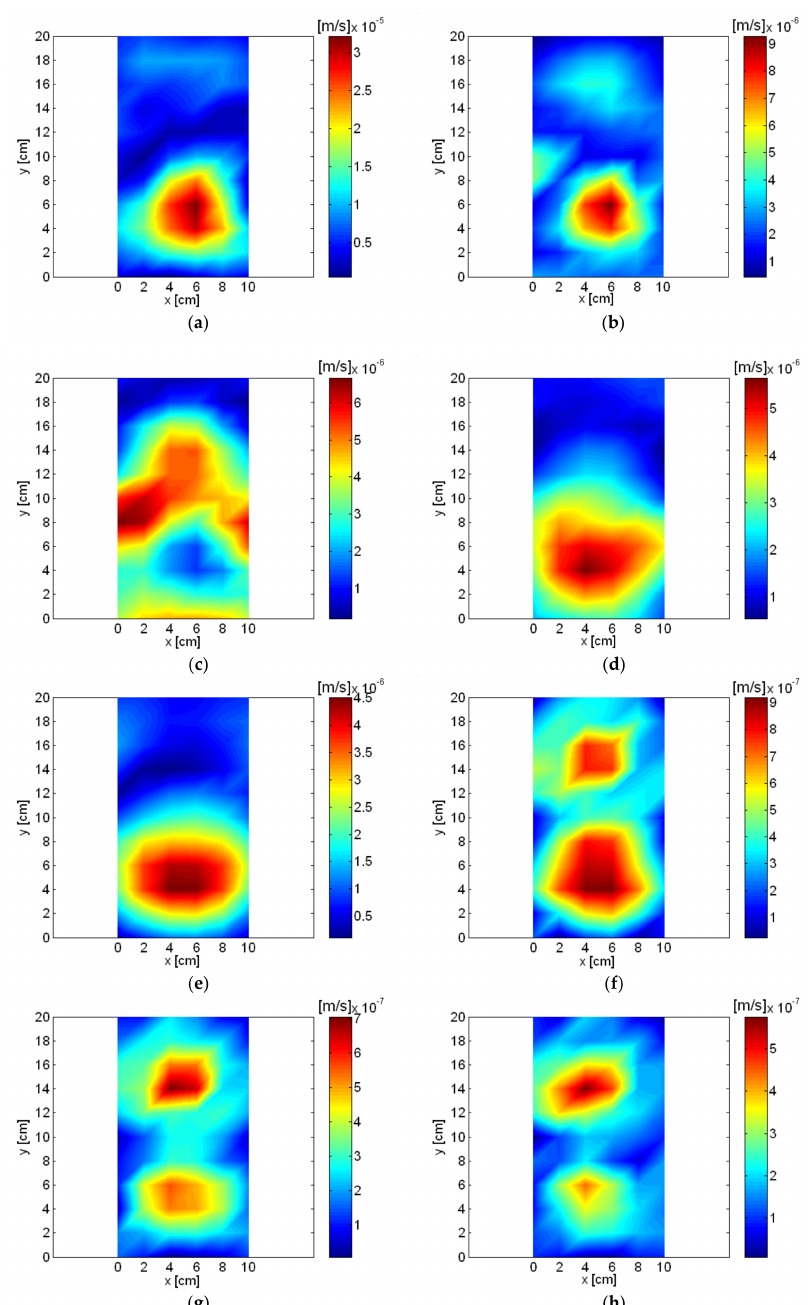
Figure 9. Reconstructed particle velocity of loudspeaker: ( a ) 300 Hz; ( b ) 1000 Hz; ( c ) 1896 Hz; ( d ) 3000 Hz; ( e ) 4000 Hz; ( f ) 7000 Hz; ( g ) 8000 Hz; ( h ) 8500